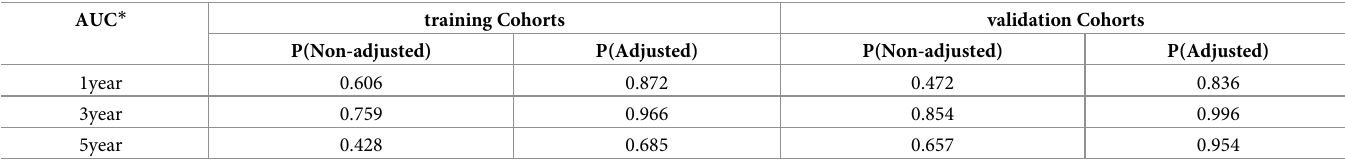
Table 4. The difference between area of AUC for the 1-, 3-, and 5-year OS probability patients with NF-pNET in training cohort and validation cohort. AUC